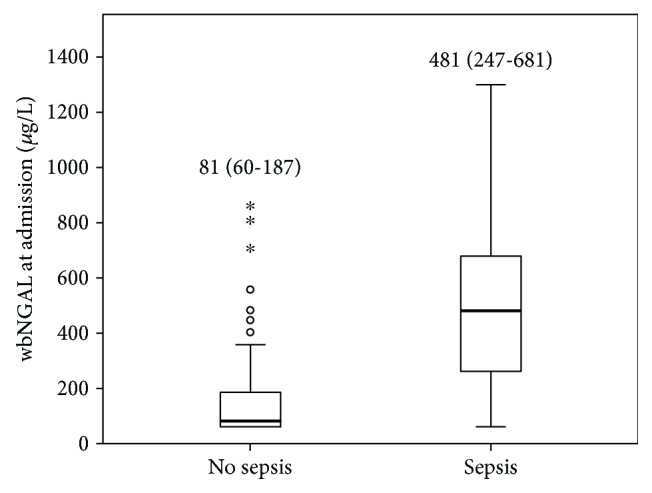
Whole-blood NGAL concentrations (μg/L) according to the presence of sepsis. Boxplots indicate the median and 25th and 75th percentiles of wbNGAL in ng/L. Whiskers indicate the 5th and 95th percentiles. Statistical significance (p). Patients without sepsis n = 71; patients with sepsis n = 29.